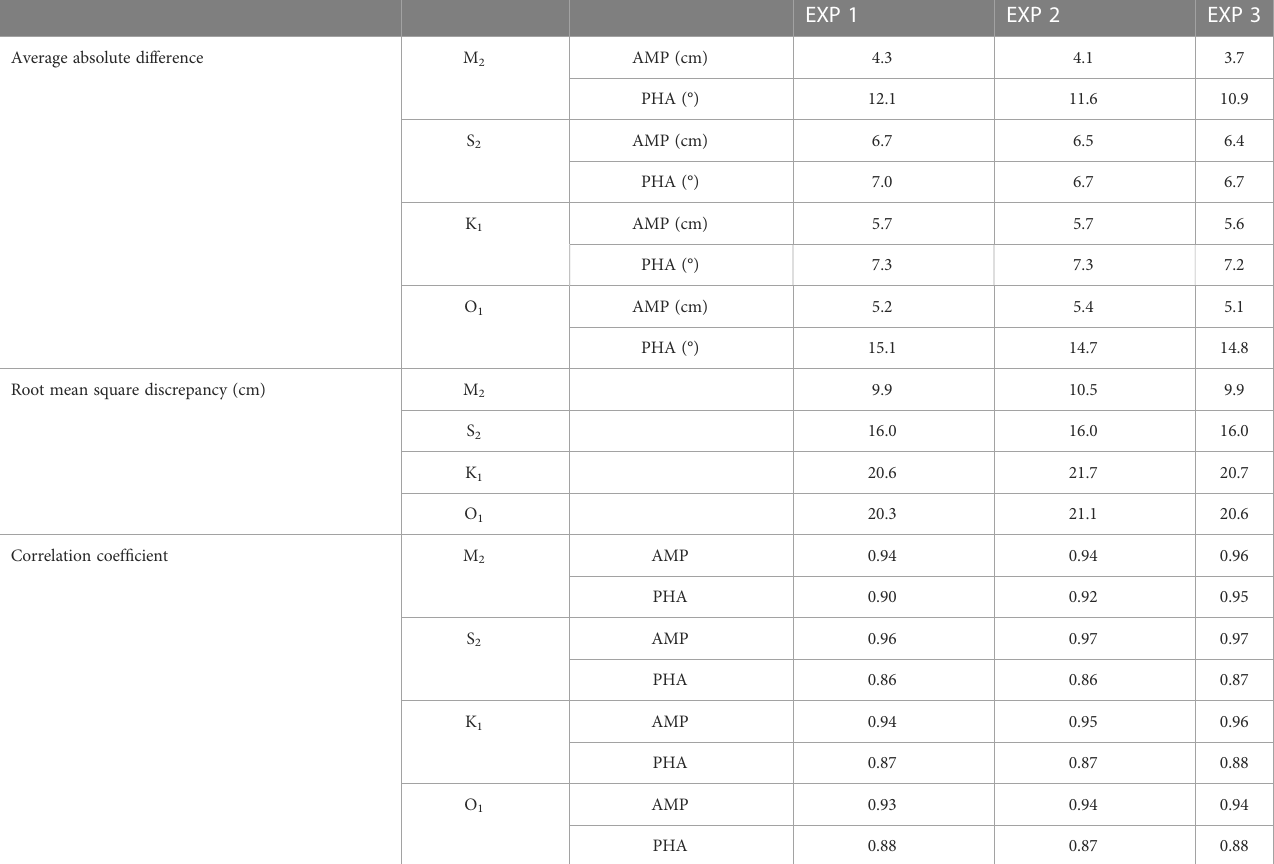
TABLE 1 The differences of tidal harmonic constants compared with observations from tidal gauge